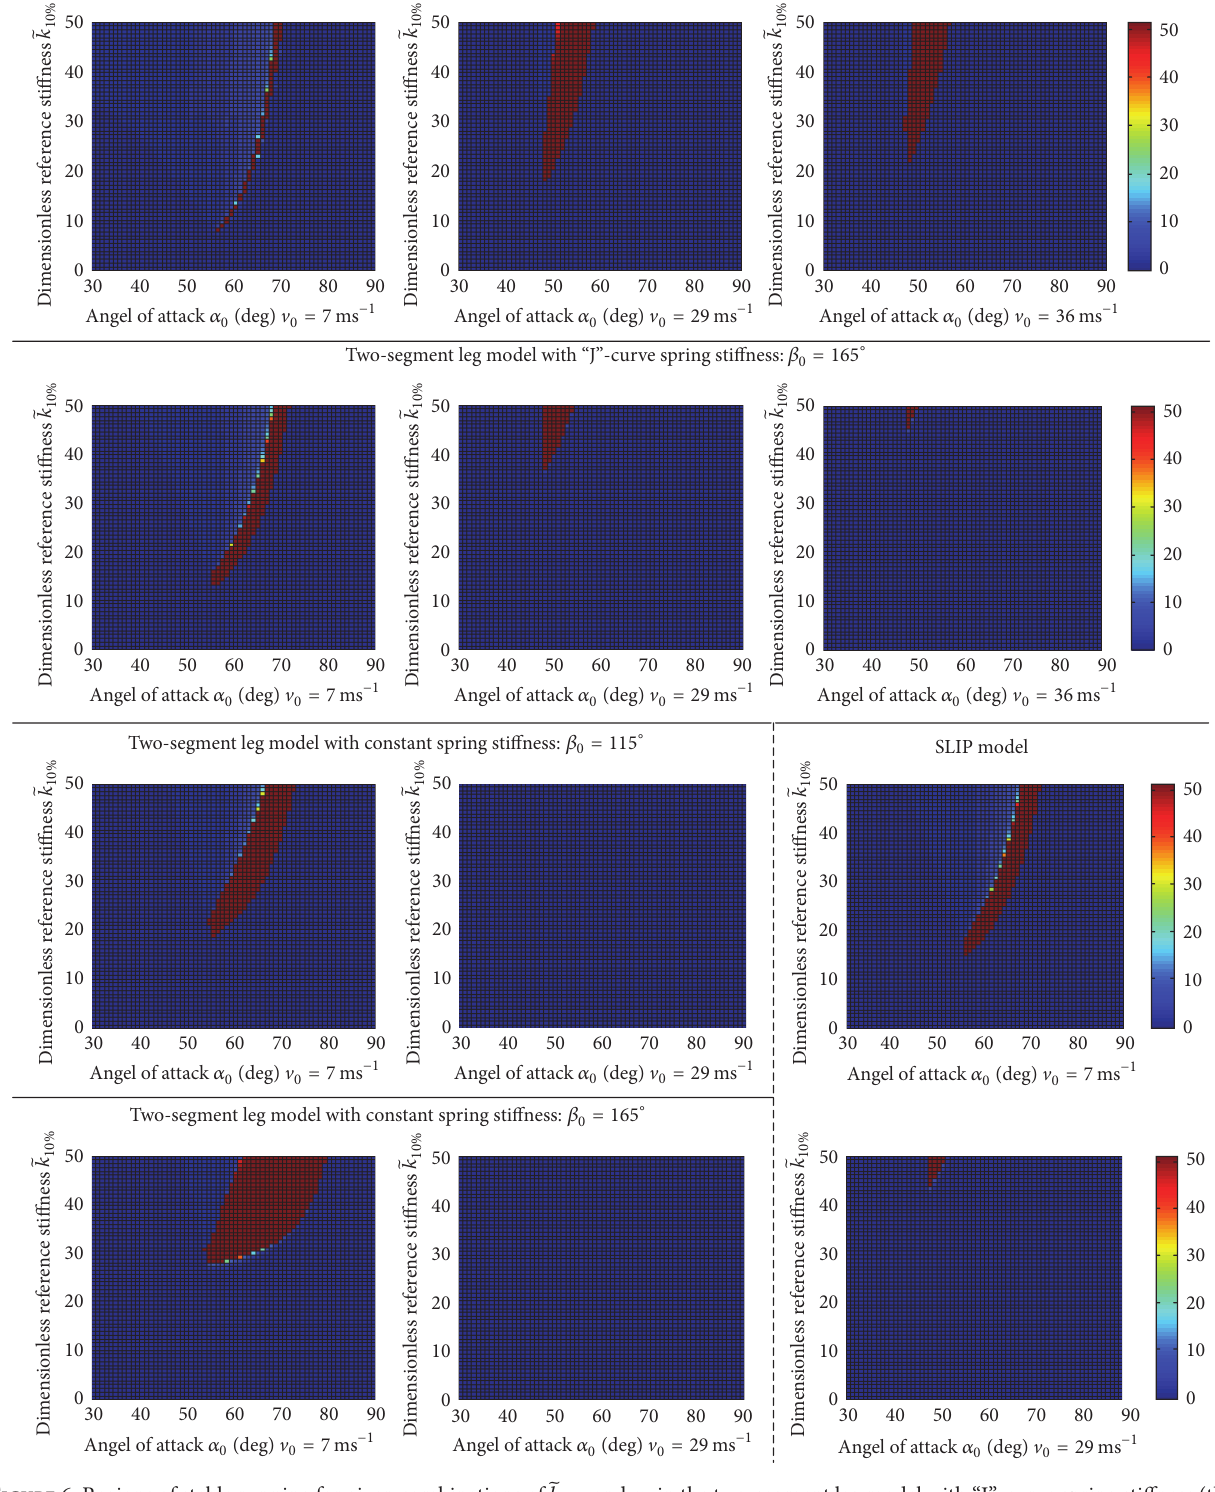
Figure 6: Regions of stable running for given combinations of first row 𝛽 0 = 115 ∘ and the second row 𝛽 0 = 165 ∘ ), the two-segment leg model with constant spring stiffness (the first and second figures of the third row 𝛽 0 = 115 ∘ and the first and second figures of the last row 𝛽 0 = 165 ∘ ) and the SLIP model (the third and fourth figures of the third